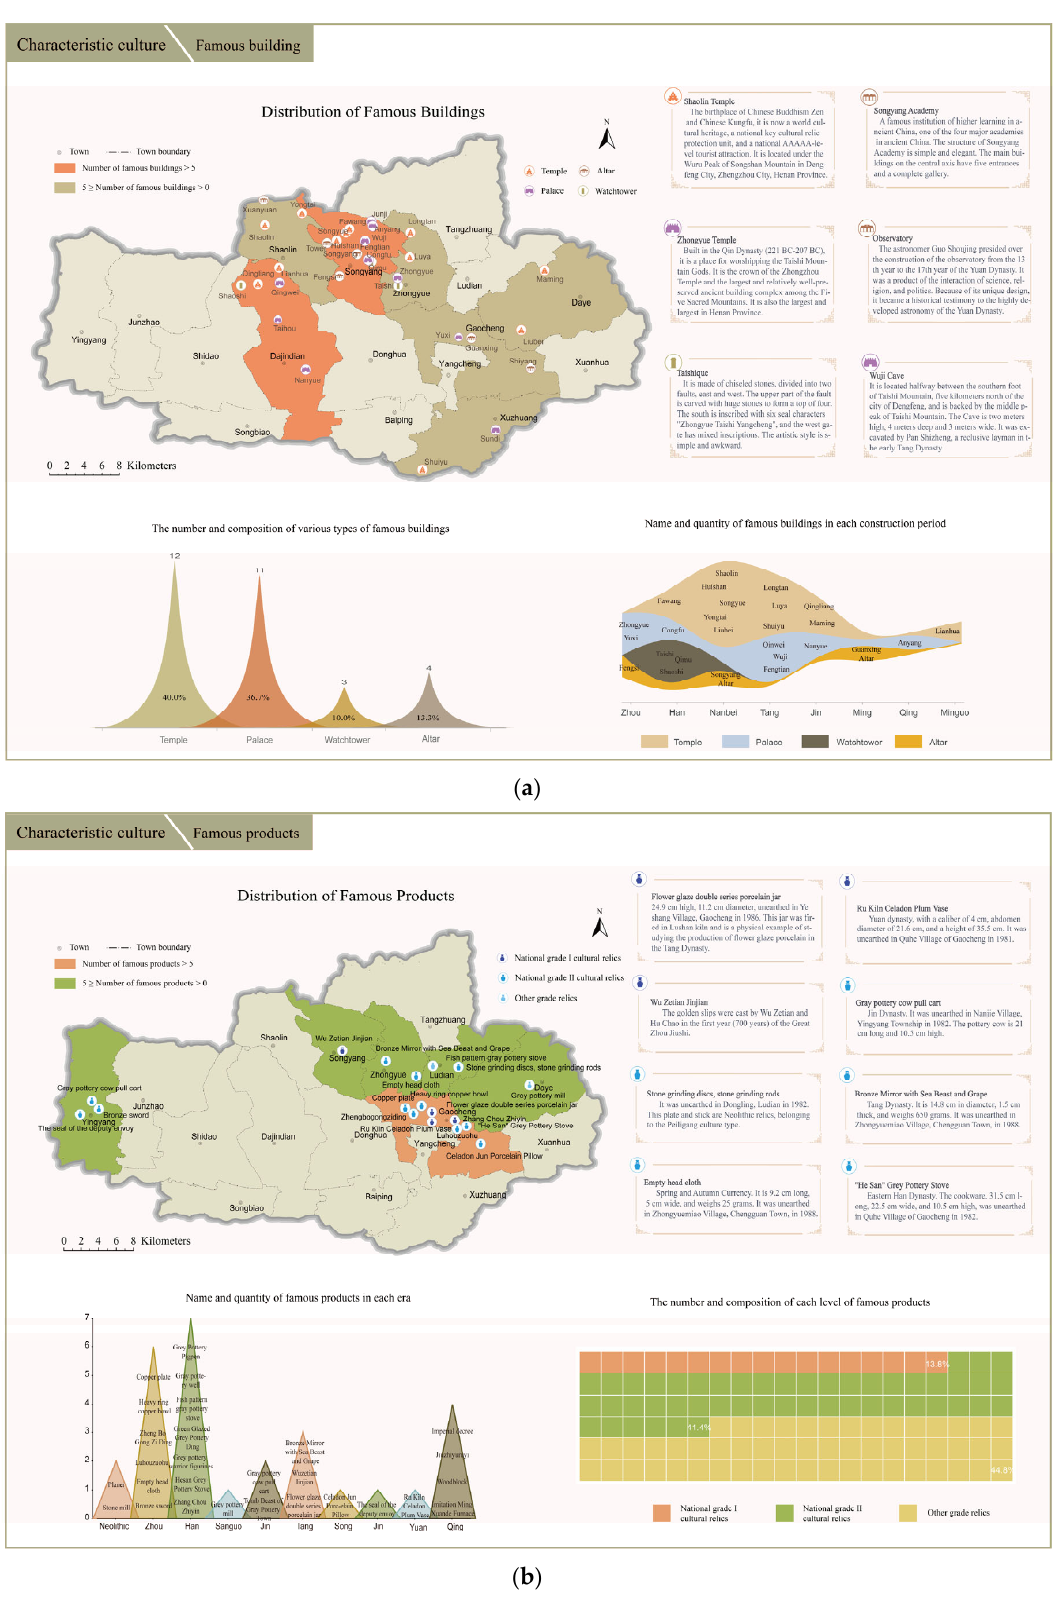
Figure 7. The front and back of the “Sign” map: ( a ) front side: map of famous buildings; ( b ) backside: map of famous products.